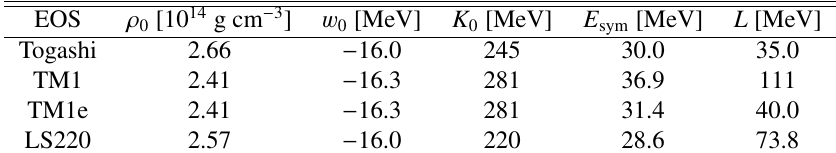
Table 1. Physical quantities at the nuclear saturation density for adopted EOSs